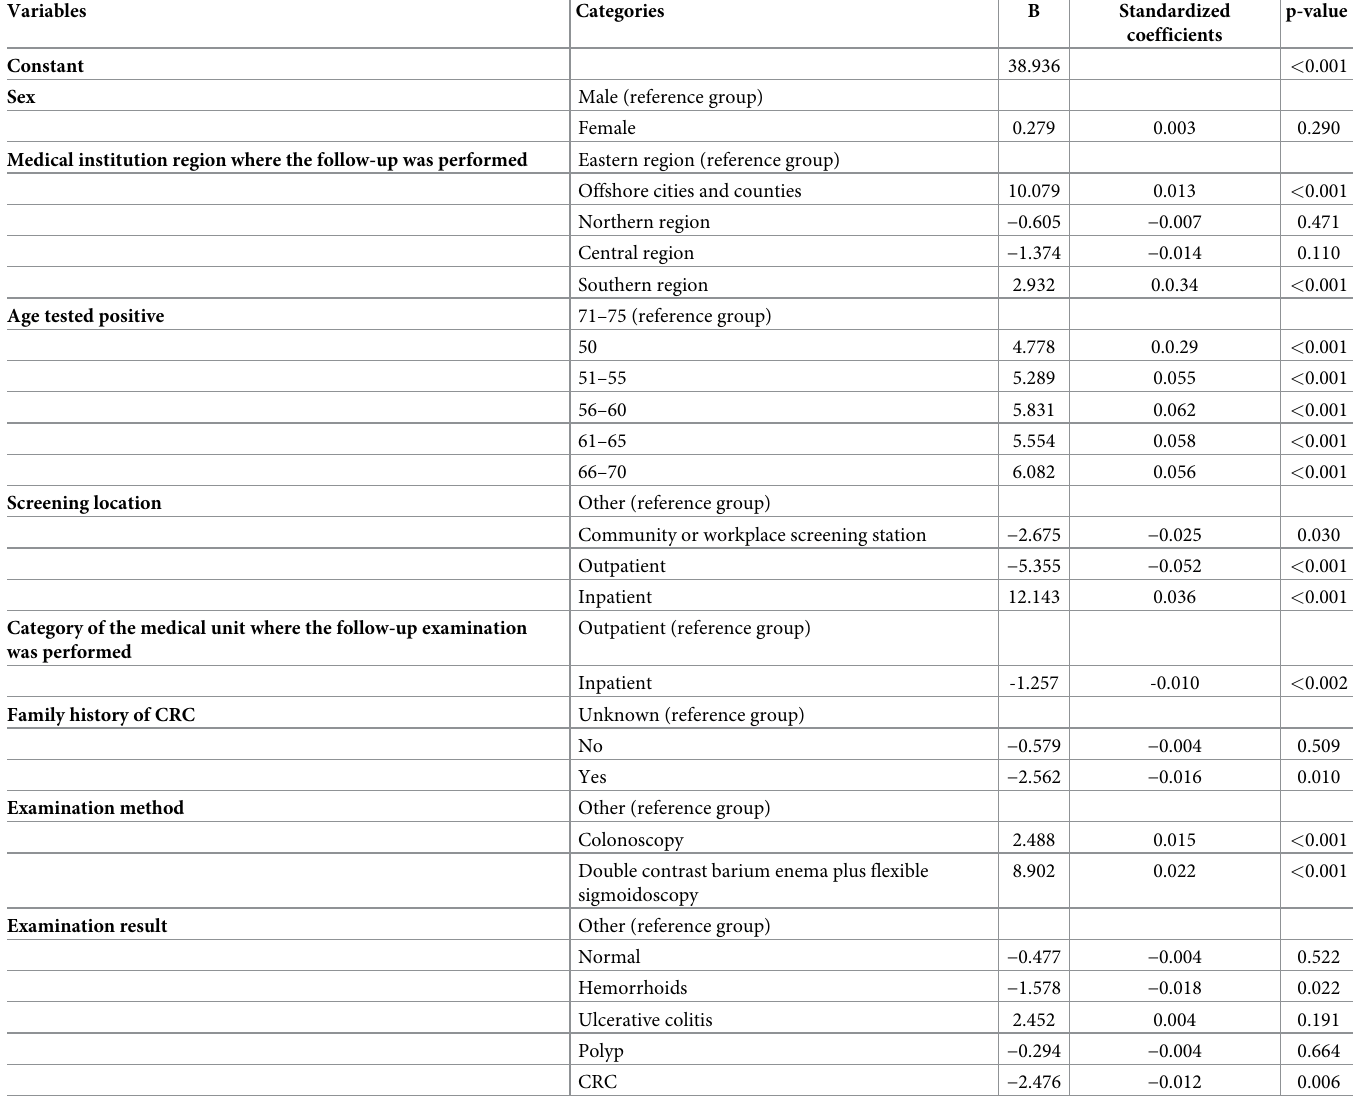
Table 4. Factors affecting the mean follow-up time in those who tested positive for